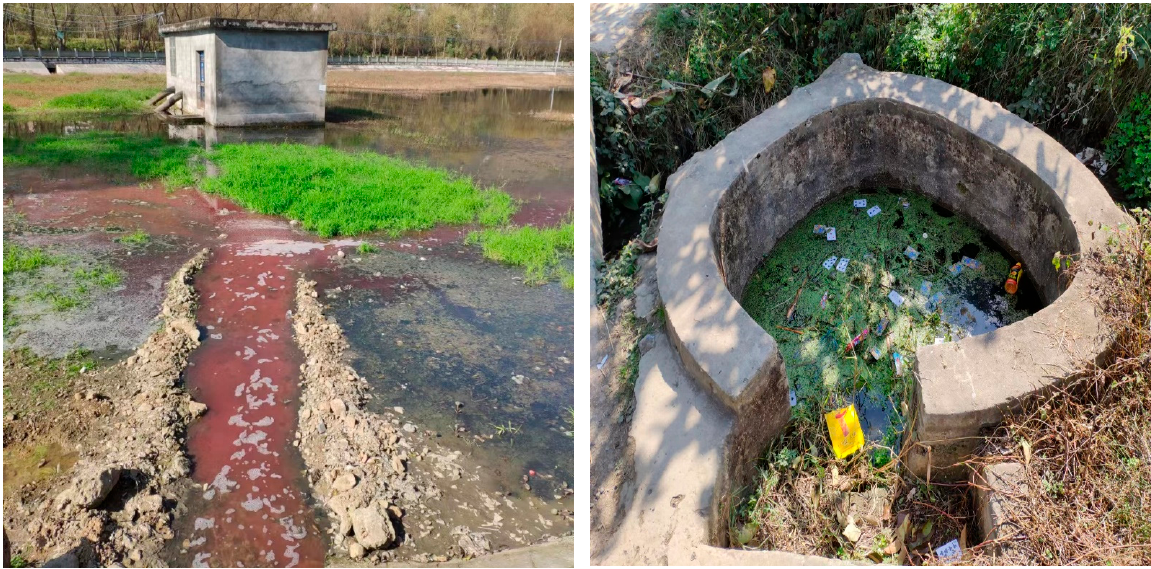
Figure 2. Perceived wastewater in the rural areas of Sichuan Province (taken in December 2018).